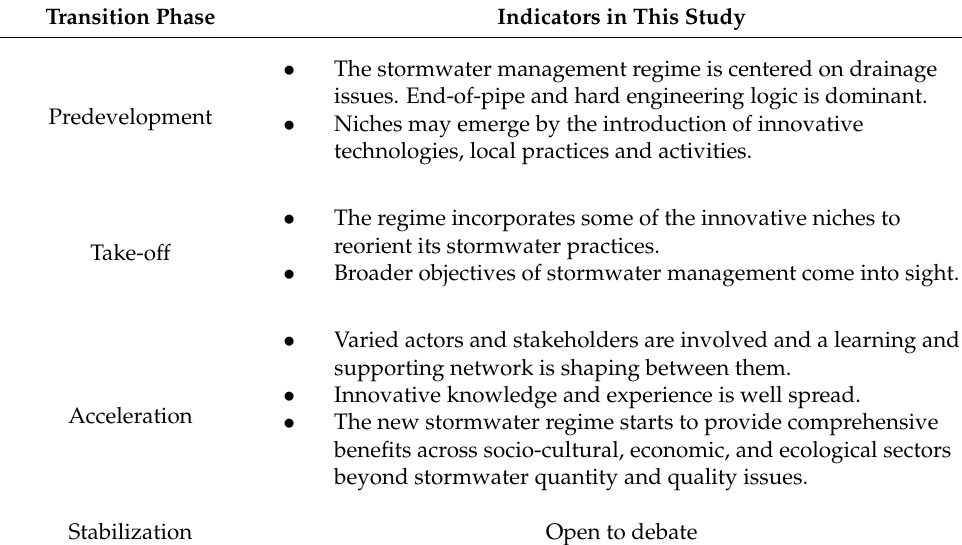
Table 1. Indicators of transition